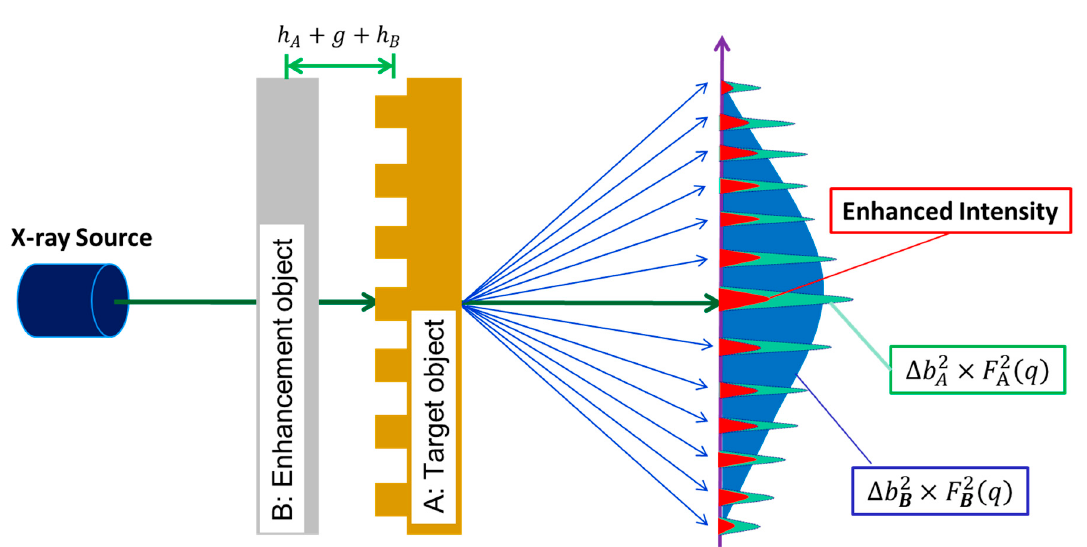
Figure 2. A schematic diagram of the tSAXS experiments for measuring the effective longitudinal coherence length. A and B denote the target grating and enhancement objects, respectively, with a gap 𝑔 between them. The value of 𝑔 is adjusted by inserting spacers with different thicknesses.